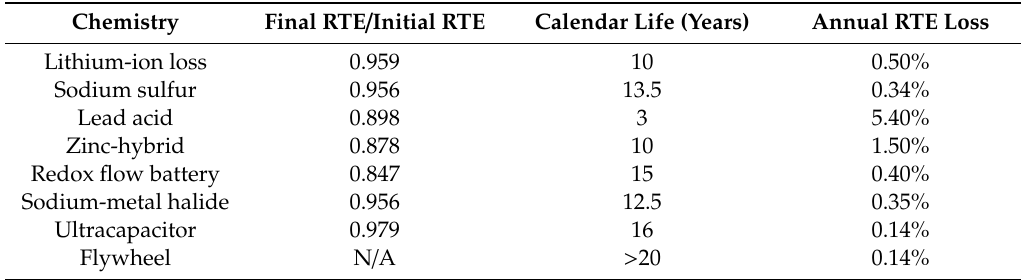
Table 6. Annual round-trip e ffi ciency (RTE) loss by battery